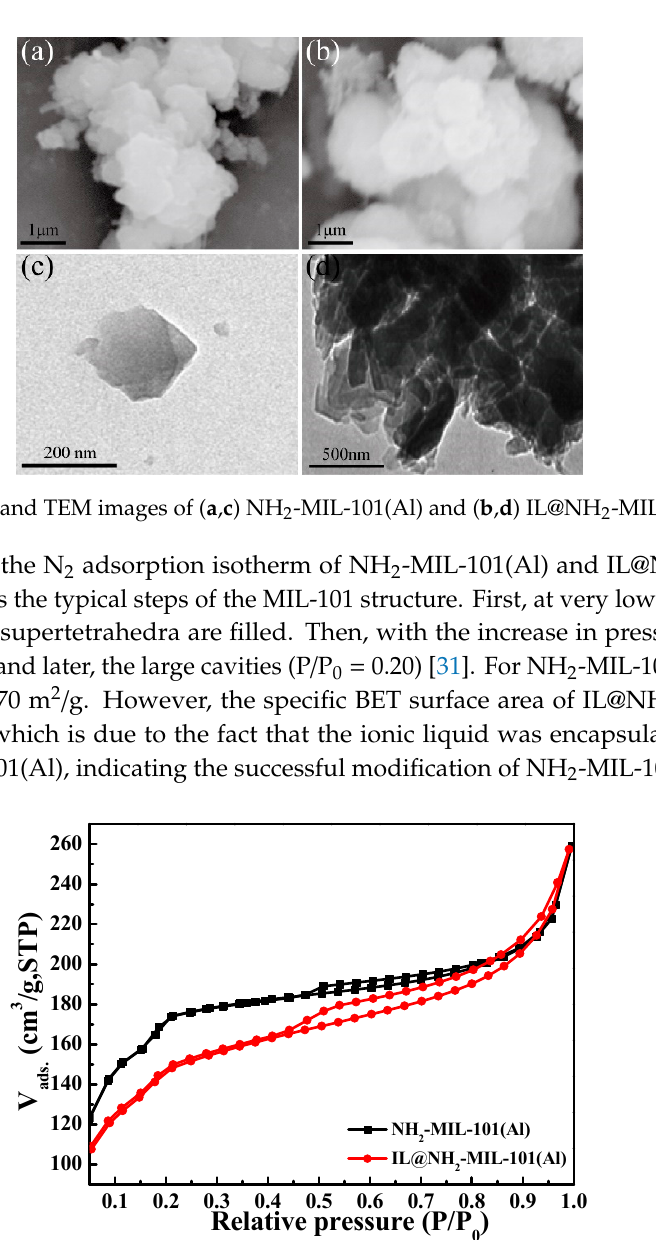
Figure 6. The N 2 adsorption isotherm of NH 2 -MIL-101(Al) and IL@NH 2 -MIL-101(Al).